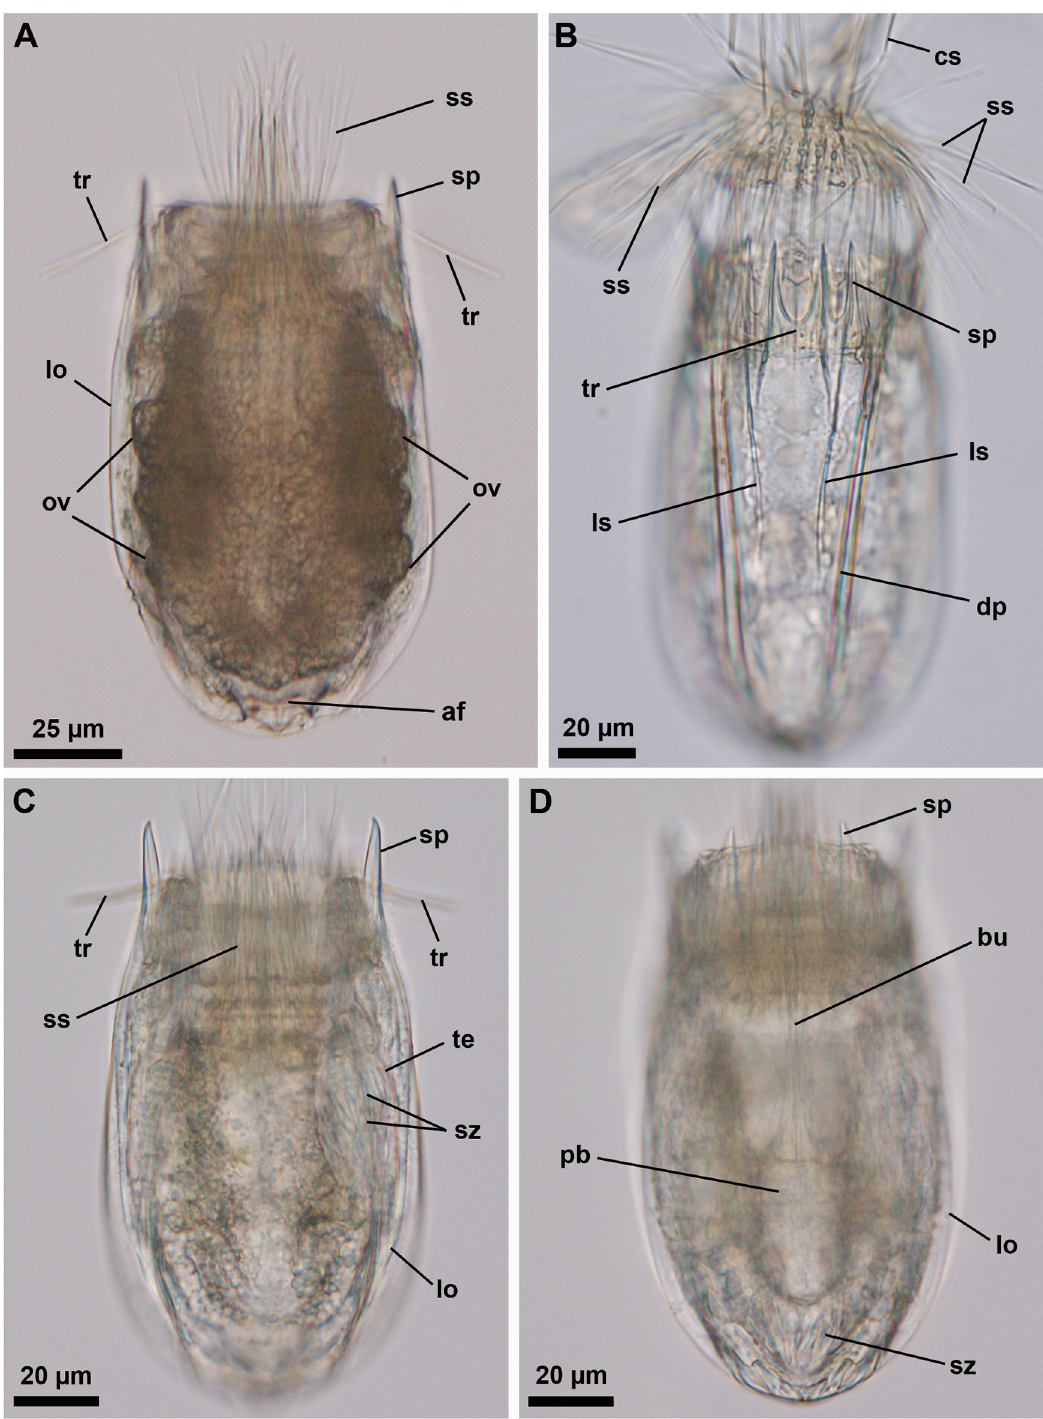
Fig 6. Light micrographs of three live specimens of Nanaloricus valdemari sp. nov. Anterior faces up in all aspects. (A) Overview of a female adult with head almost fully retracted. Internally, note the presence of the large ovaries (ov) in the abdomen. (B) Overview of a female adult (different from that shown in A). Note the pair of longitudinal stripes (ls) spanning the anterior two thirds of the dorsal plate of the lorica. (C and D) Overview of a male adult with head almost fully retracted. Note the presence, within the abdomen, of a testis (te) containing spermatozoa (sz). Note also the relative position of the pharyngeal bulb (pb) in this retracted animal. Abbreviations: af, anal field; bu, buccal tube; cs, clavoscalid; dp, dorsal plate; lo, lorica; sp, anterior spike; ss spinoscalid; tr,